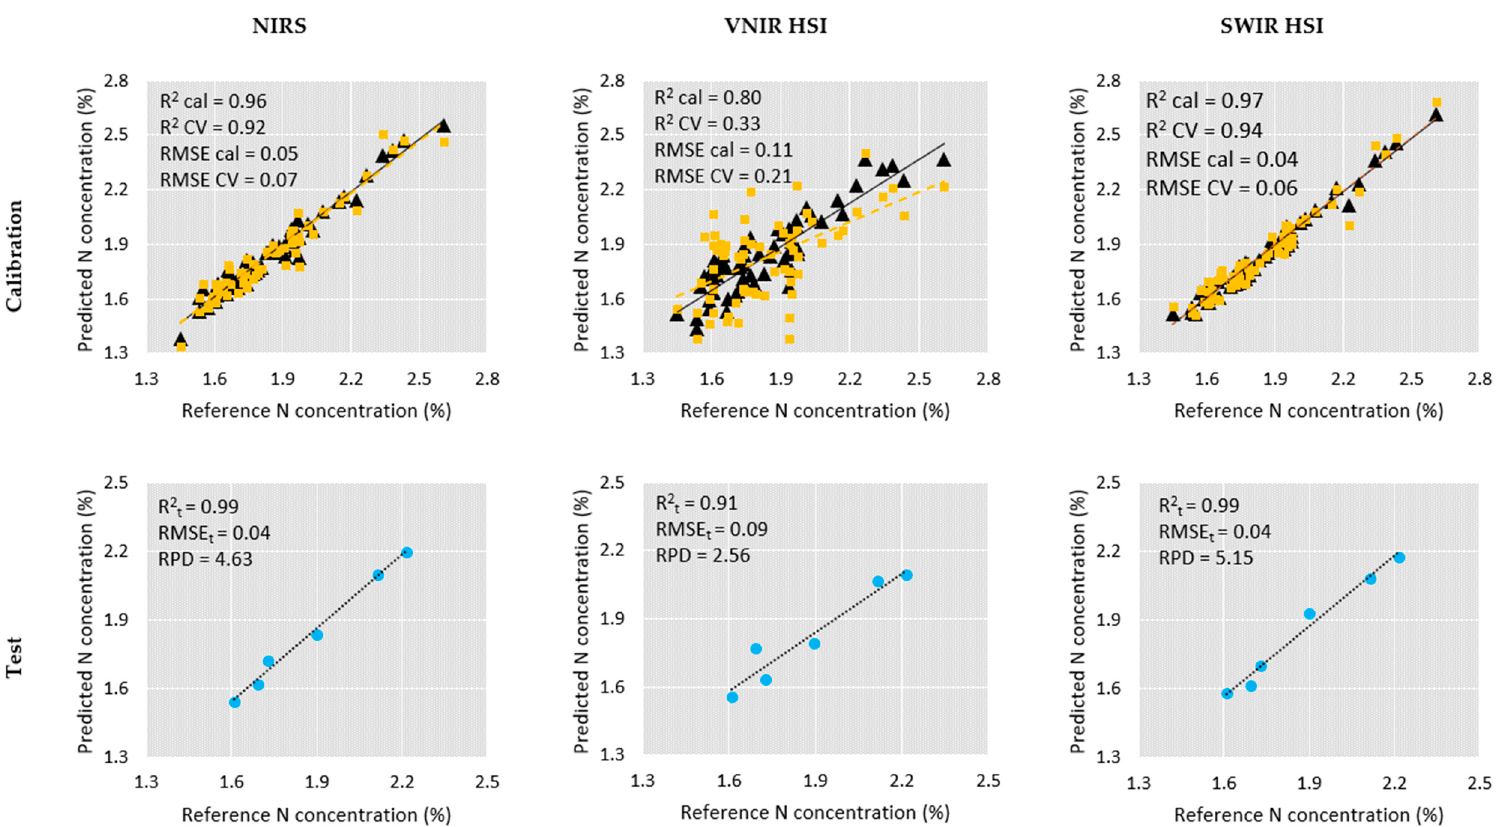
Figure 5. Nitrogen concentration (%) in feed samples analysed using the near infrared spectroscopy (NIRS, 400–2500 nm), visible to near infrared hyperspectral imaging (VNIR HSI, 400–1000 nm) and short-wave infrared HSI (SWIR HSI, 1000–2500 nm) in the calibration set and in the test set. Predictions in the calibration (cal) and cross-validation (CV) sets are presented in close triangles (solid lines) and squares (dashed lines), respectively. Predictions in the test set ( t ) are presented in close circles (dotted line).